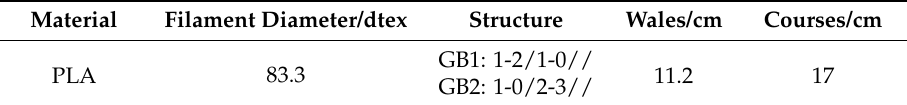
Table 1. Sample parameter of warp-knitted fabrics.